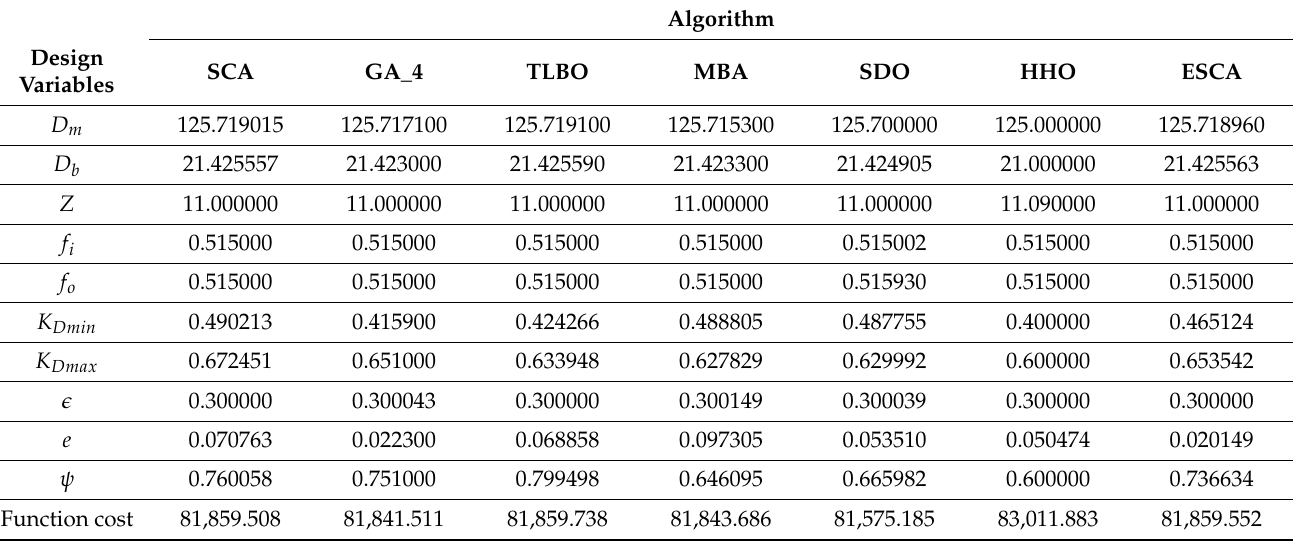
Table 28. Design variables and comparison of the best solutions obtained for the rolling element bearing design problem.